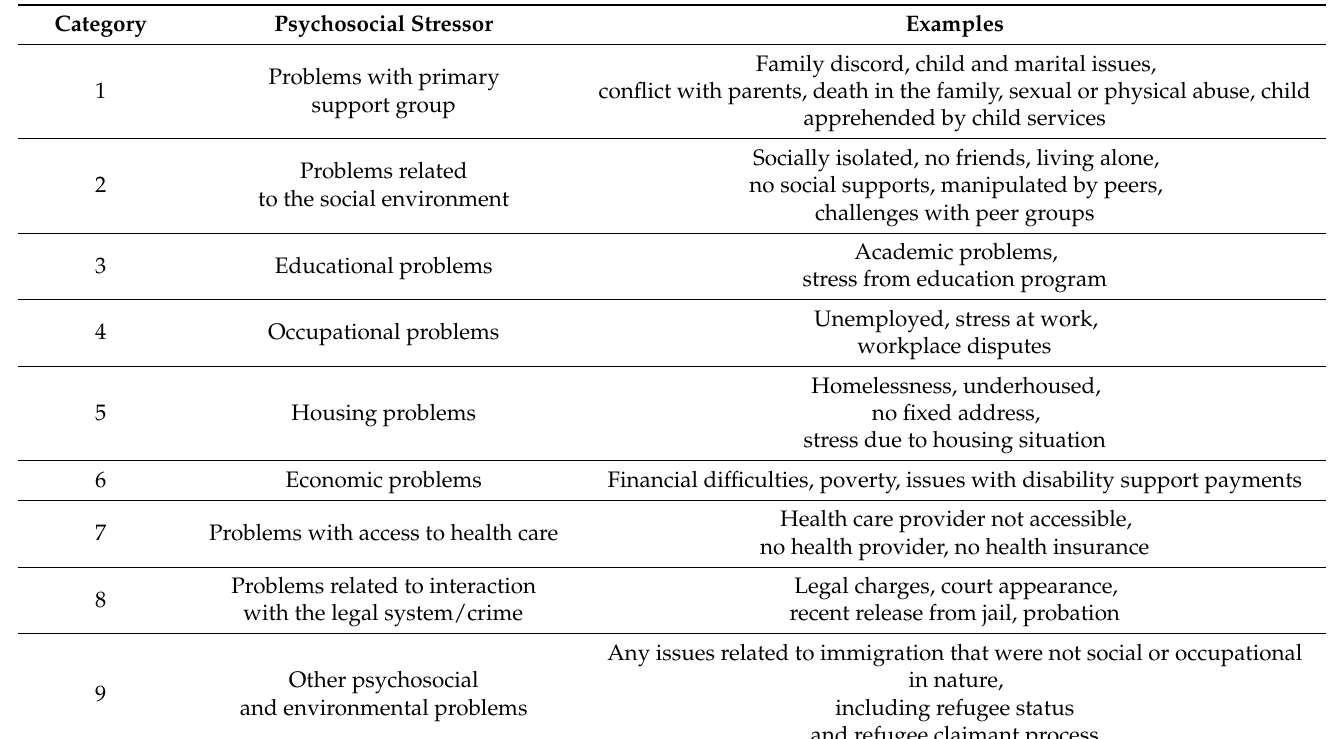
Table 1. Psychosocial stressors according to the